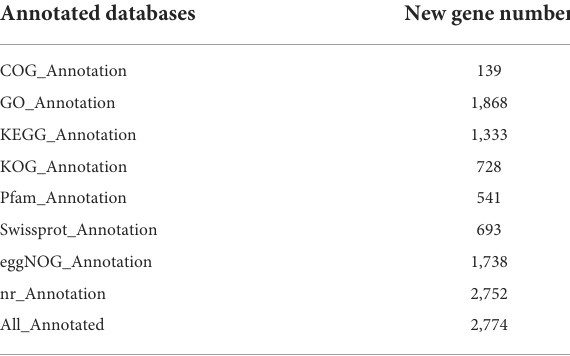
TABLE 2 Function annotation result of new gene.